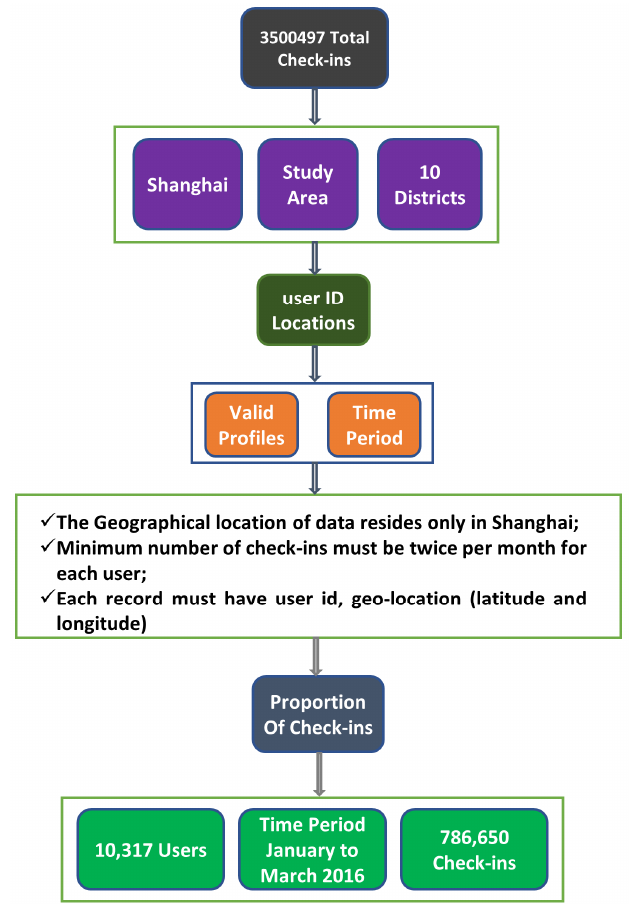
Figure 2. Criteria.